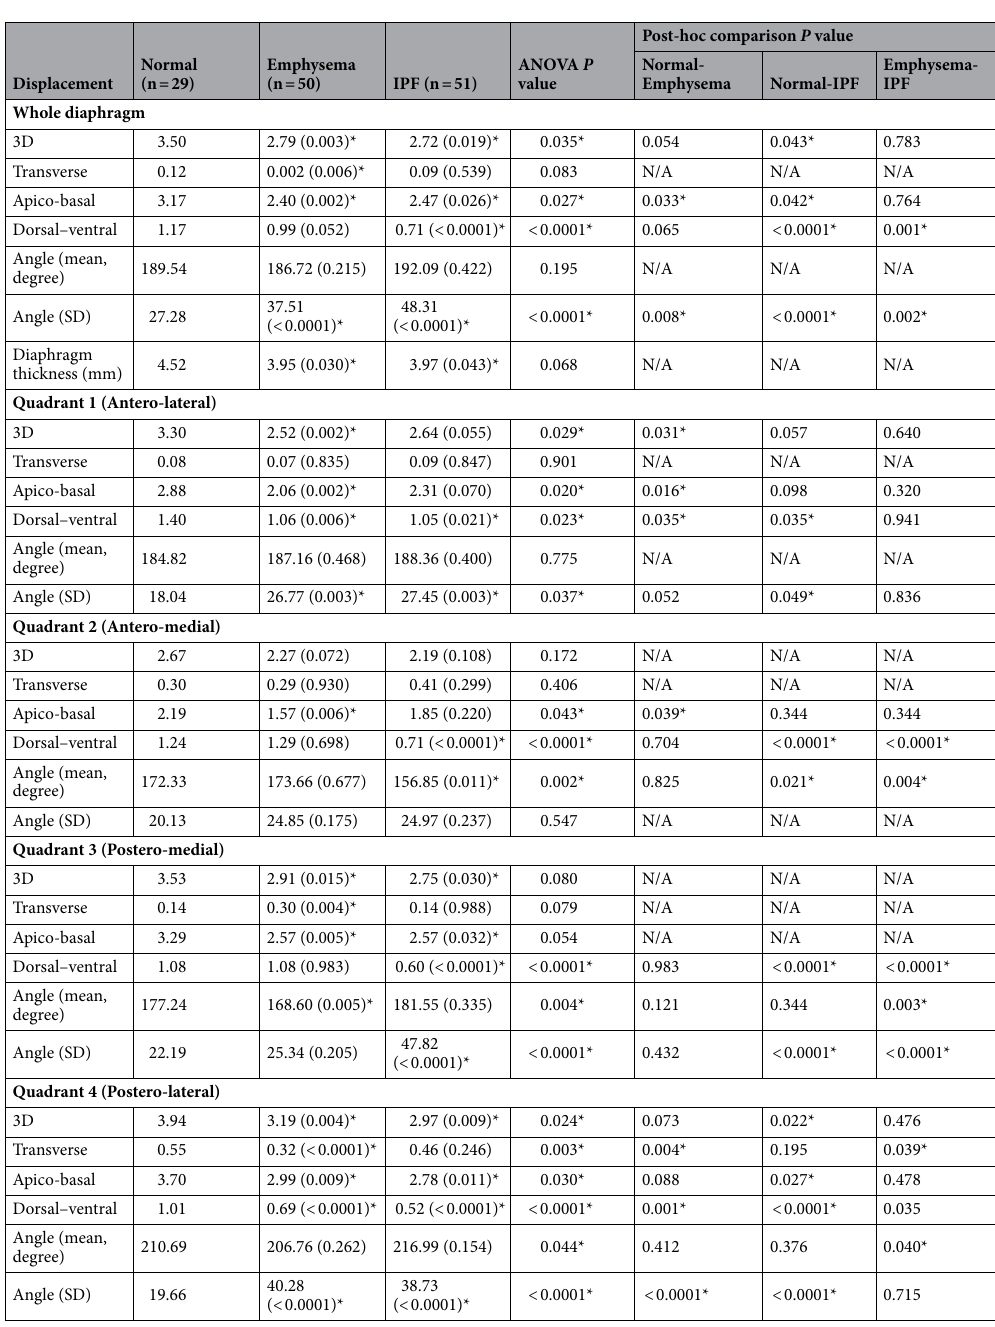
Table 1. Results of the comparison among normal, emphysema, and IPF groups. Numbers in the parentheses are P values from the independent t-test. For post-hoc analysis, P values were adjusted by holm method when the ANOVA test was statistically significant. P values with asterisk* indicate to be statistically significant N/A = not